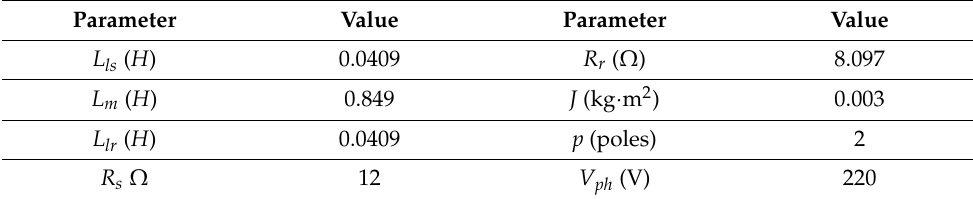
Table 3. Six-phase induction motor parameters.